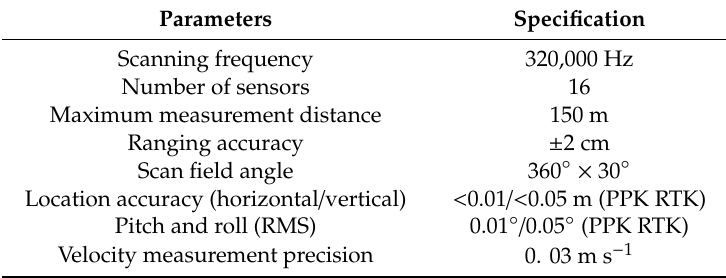
Table 1. Main technical parameters of the LR1601-IRIS laser scanner